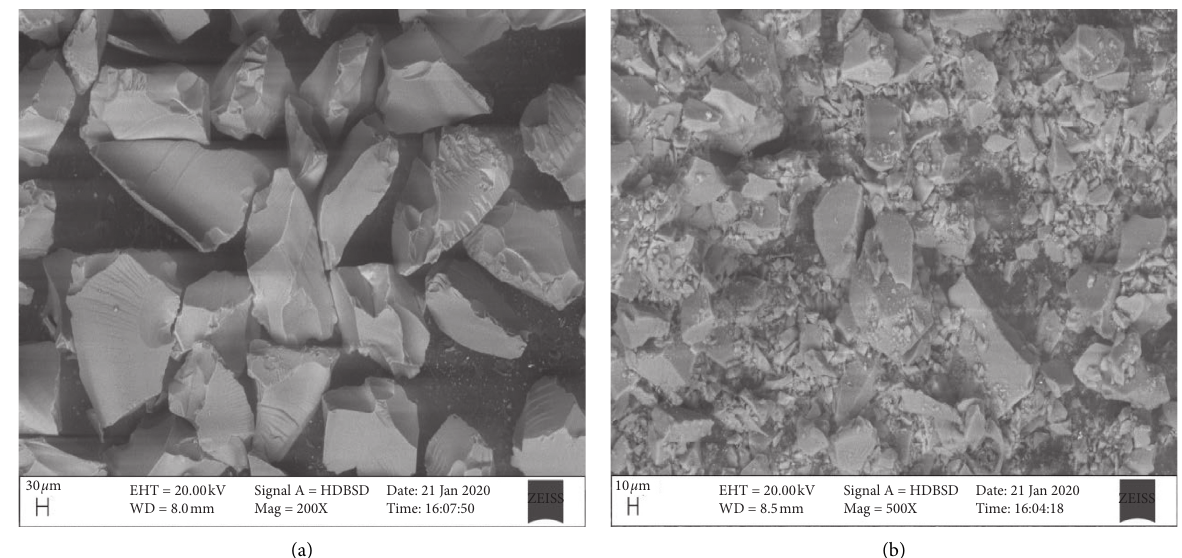
Figure 6: SEM photograph of (a) silica gel and (b) Si-H + catalyst.